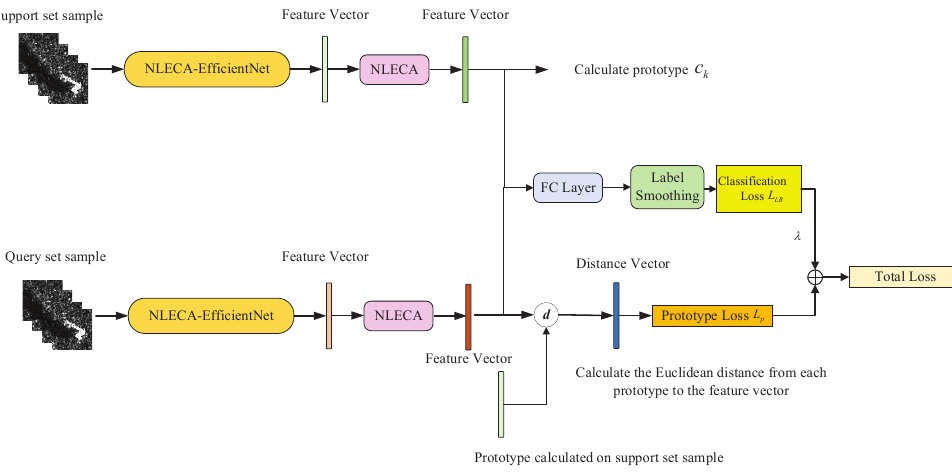
Figure 9. Schematic diagram of model training process.